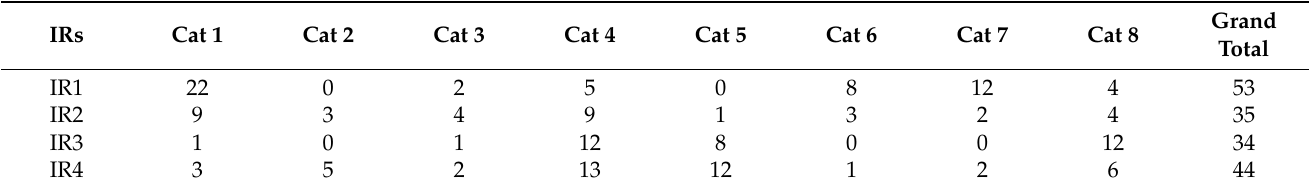
Table A2. Summary table of the positive outcomes ( N = 134) in categories (Cat 1–8) a and contributed by intermediate results (IRs) b .